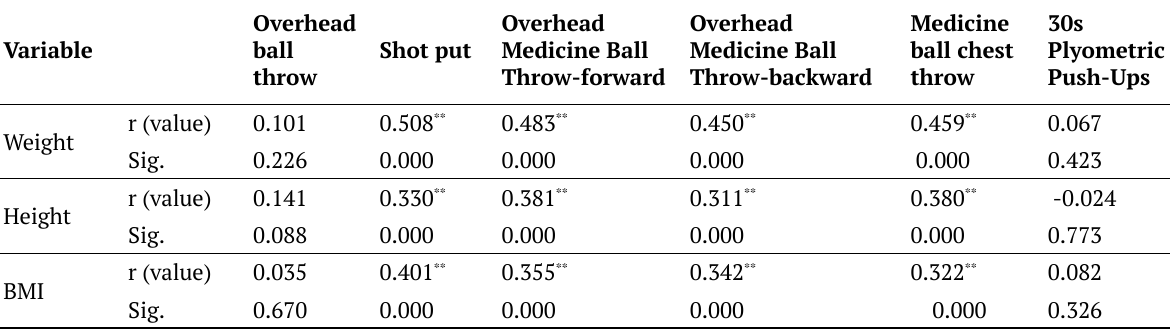
Table 8. The value of Pearson correlation coefficients between anthropometric indicators and upper body explosive strength